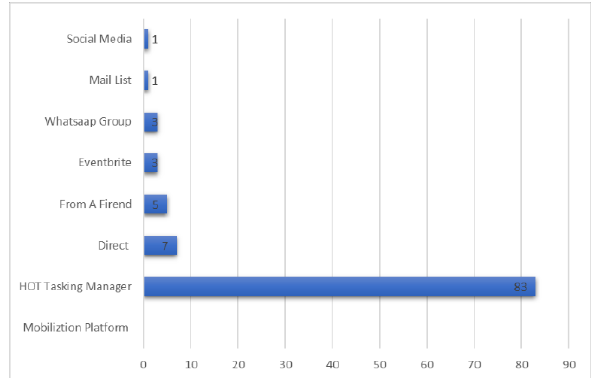
Figure 11: Mapathon Publicity Platforms for Mobilization of Mappers